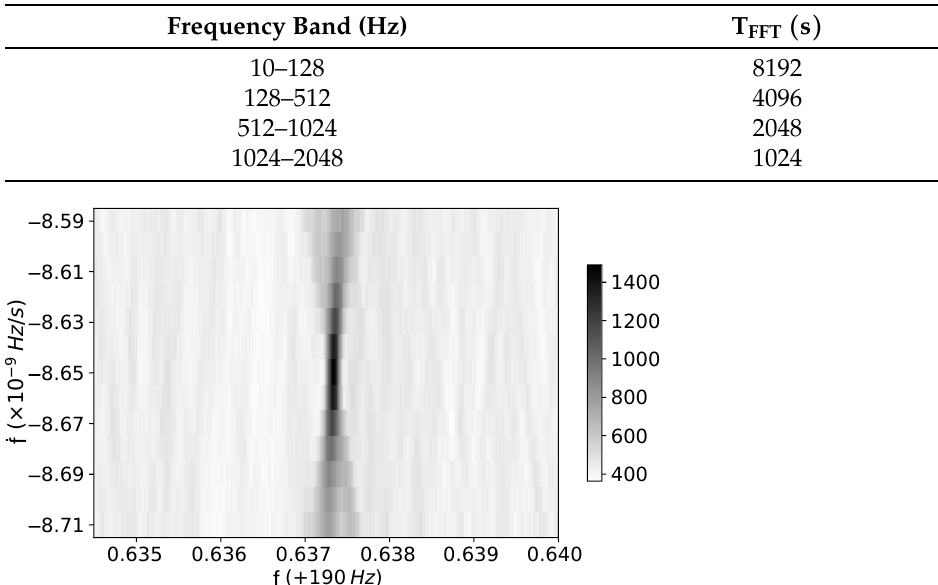
Table 1. Frequency range and T FFT for the four frequency bands used in this analysis.